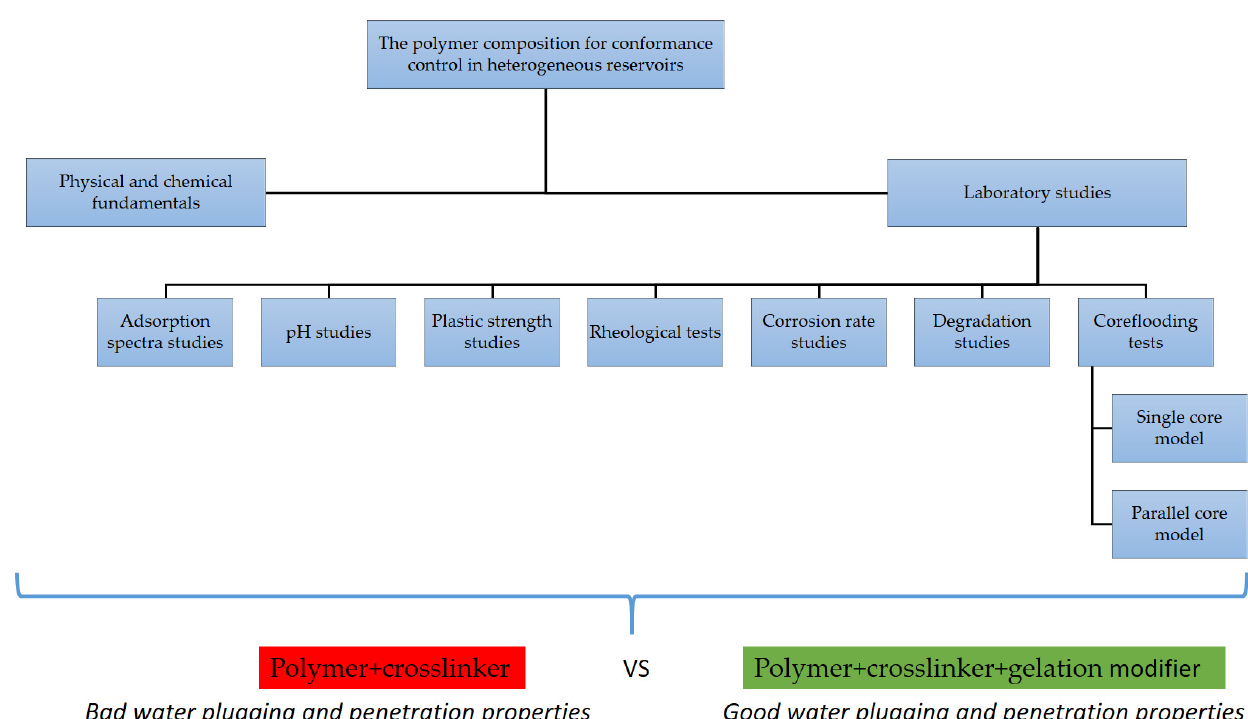
Figure 2. Enlarged research methodology.